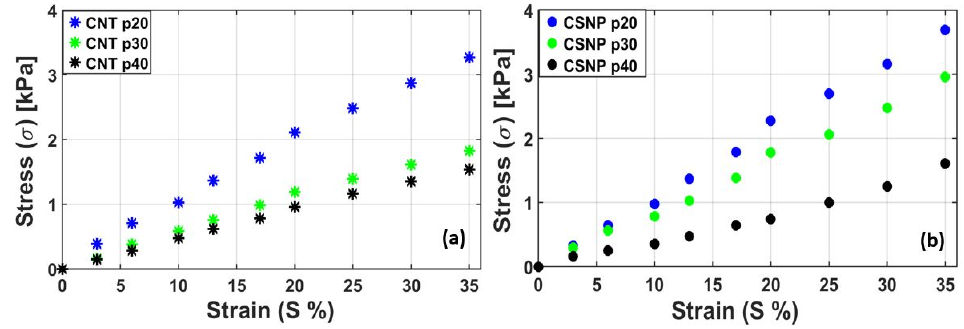
Figure 7. Stress–strain curves for the free-standing nanocomposites: ( a ) CNT-PDMS and ( b ) CSNP- PDMS.